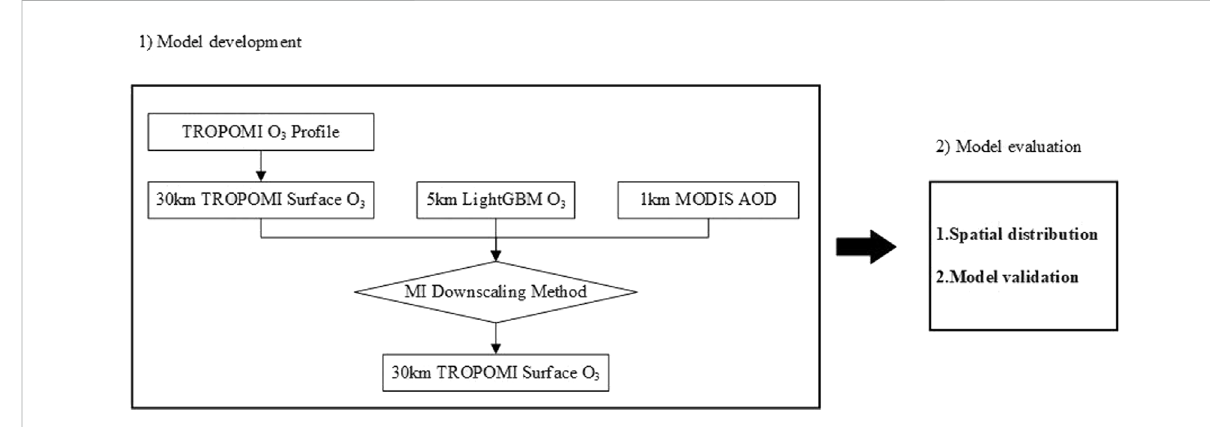
FIGURE 5 Process fl ow diagram for downscaling transformation of surface O 3 concentration guided by mutual information entropy.